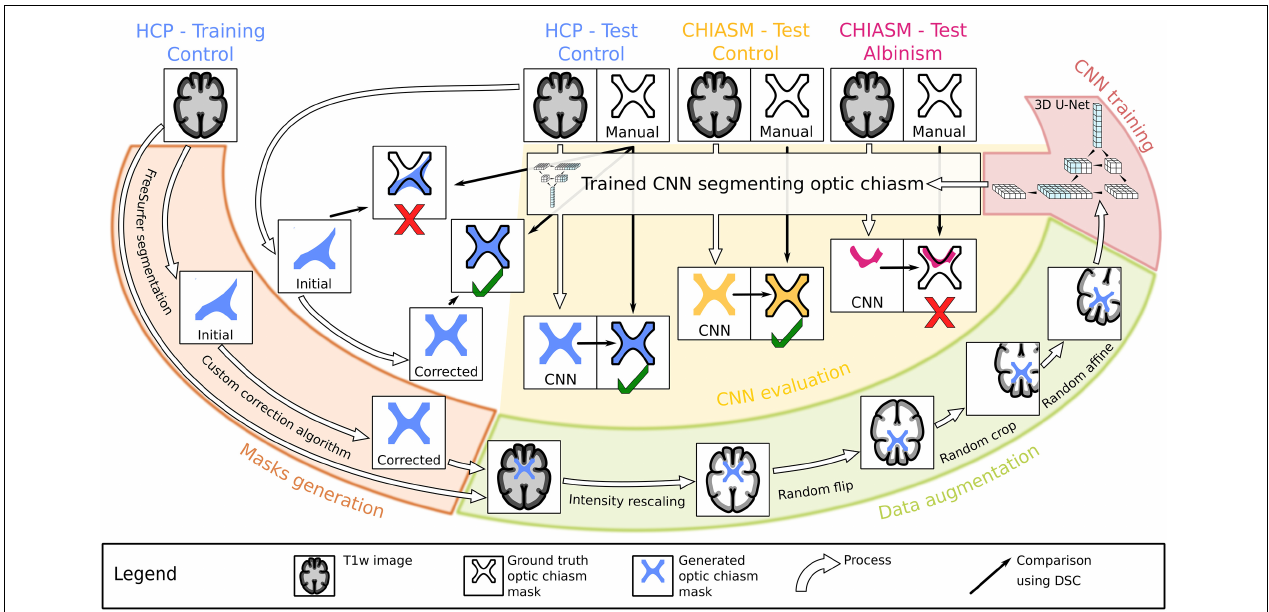
FIGURE 1 | Workflow chart. Graphical illustration of the experiment design. Initially, the training T1w images from the Human Connectome Project (HCP) dataset (top left) were used to generate accurate optic chiasm masks (“Mask generation”; marked by the orange color, left) in a two-step procedure validated on test T1w images. The image–mask pairs were subsequently preprocessed (“Data augmentation”; marked by the green color, bottom right) and used as an input target in the supervised training of the CNN (“CNN training”; marked by the red color, top right). In the final step, the test T1w images from both controls and PWA were used in evaluation of the CNN’s performance (“CNN evaluation”; marked by the yellow color,